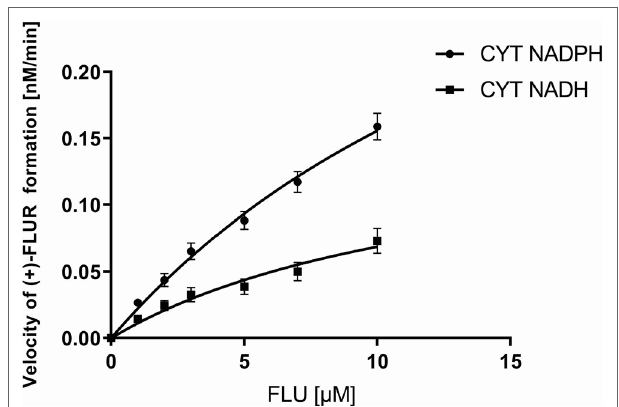
FIGURE 3 | Kinetics of flubendazole (FLU) reduction in pooled human liver cytosolic fraction of both sexes (CYT). CYT was incubated with 1.0 to 10.0 µM FLU with coenzyme NADPH or NADH. The values represent the mean ± standard deviation of three independent experiments.